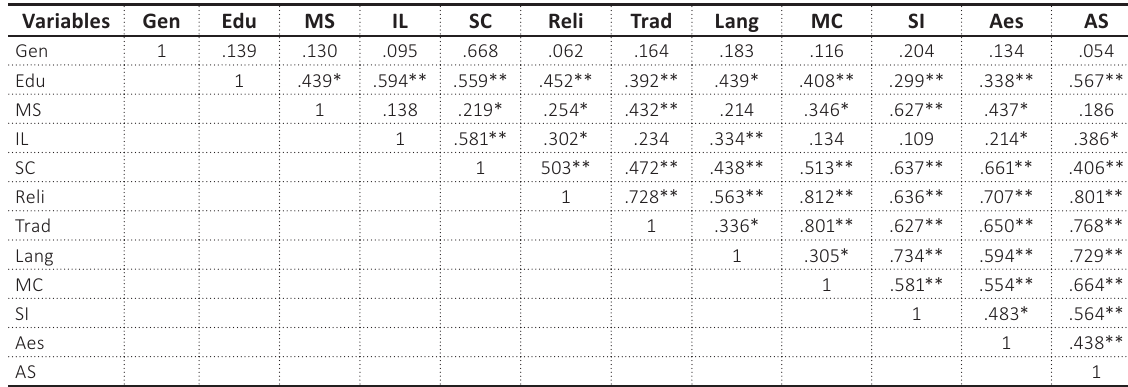
Source: Primary data